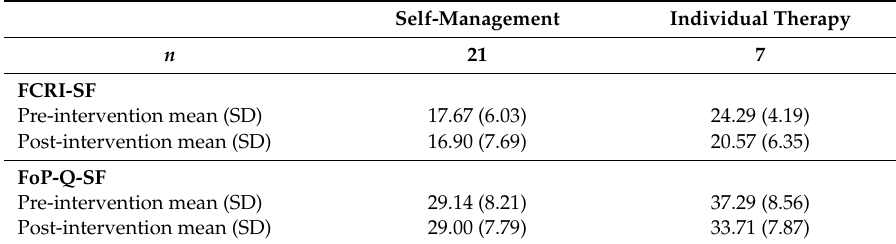
Table 2. Stepped-care pre- and post-intervention scores on FCRI-SF and FoP-Q-SF.